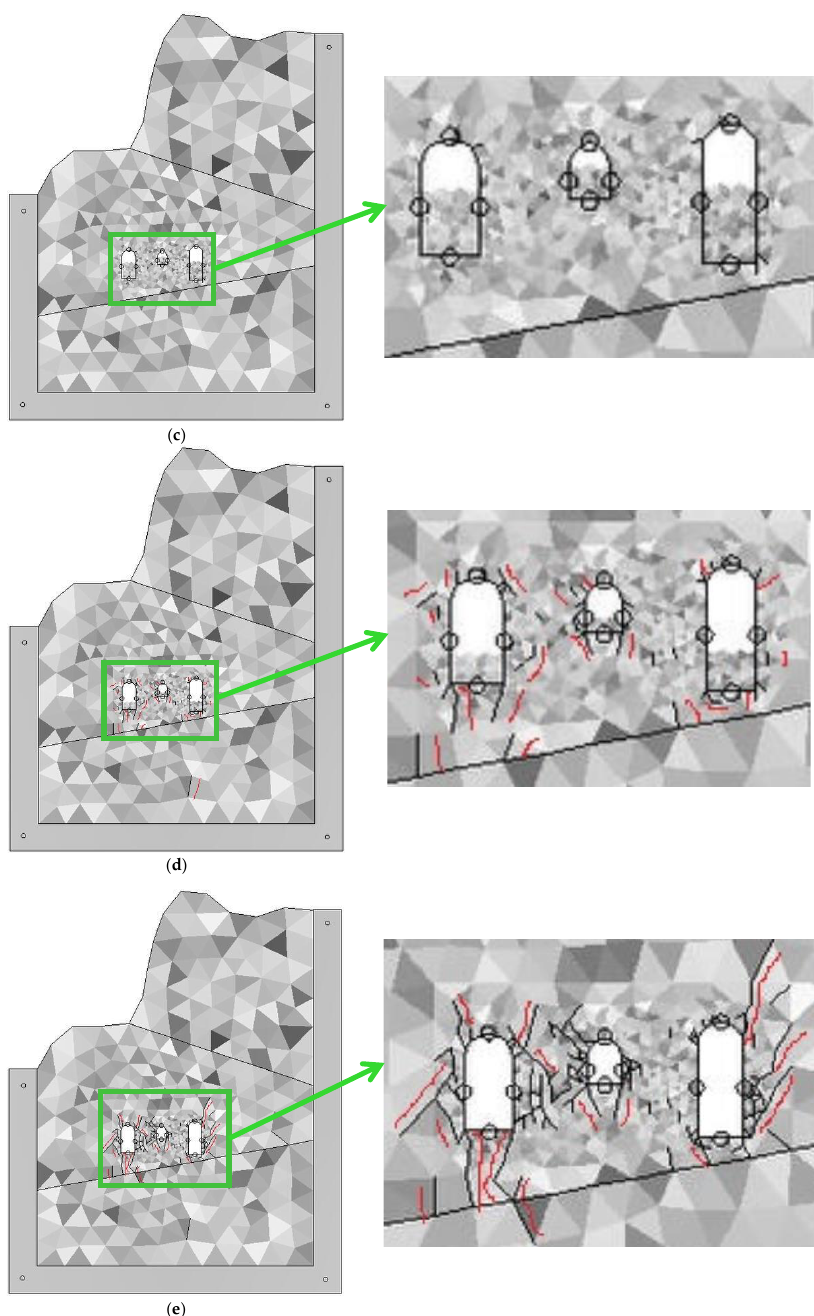
Figure 7. Failure process of SR of the underground cavern group during excavation in Scheme 3: ( a ) The excavation began; ( b ) the 1st step of excavation is completed; ( c ) the 2nd step of excavation is completed; ( d ) the 3rd step of excavation is completed; ( e ) the 4th step of excavation is completed. From Figure 7, after the excavation of Scheme 3 began, small cracks appeared in the surrounding rocks of the arch’s right side of the MP cavern and the arch’s left side and the bottom floor ’s lower right corner of the TST cavern, as shown in Figure 7a. With the pro- gression in excavation, cracks did not further increase and expand after the end of the second step of excavation, as shown in Figure 7b – c. After the third step of excavation was over, the cracks around the cavern group gradually increased and expanded. Long cracks appeared in the surrounding rocks of the bottom floor ’s lower left and right corners of the MP cavern and MTC cavern, small cracks appeared in the surrounding rocks of the bot- tom floor ’s lower left and right corners of the TST cavern, and cracks in the arch of the surrounding rocks of the three caverns also increased and expanded, while multiple fis- sures appeared in fault f2, as shown in Figure 7d. After the fourth step of excavation, the cracks in the surrounding rocks of the three caverns were further increased and expanded. Among them, the cracks in the surrounding rocks of the arch, the left and right walls, and the bottom floor of the MP cavern expanded to be long cracks, the cracks in the right wall SR of the MP cavern extended and connected with the cracks in the left wall SR of the MTC cavern and the cracks in the bottom floor of the MP cavern were connected with the fault f2. The cracks in the surrounding rocks of the arch’s right side and the right wall of the TST cavern extended into long cracks, and the cracks in the bottom floor SR of the tailrack surge tank were connected with fault f2, as shown in Figure 7e.